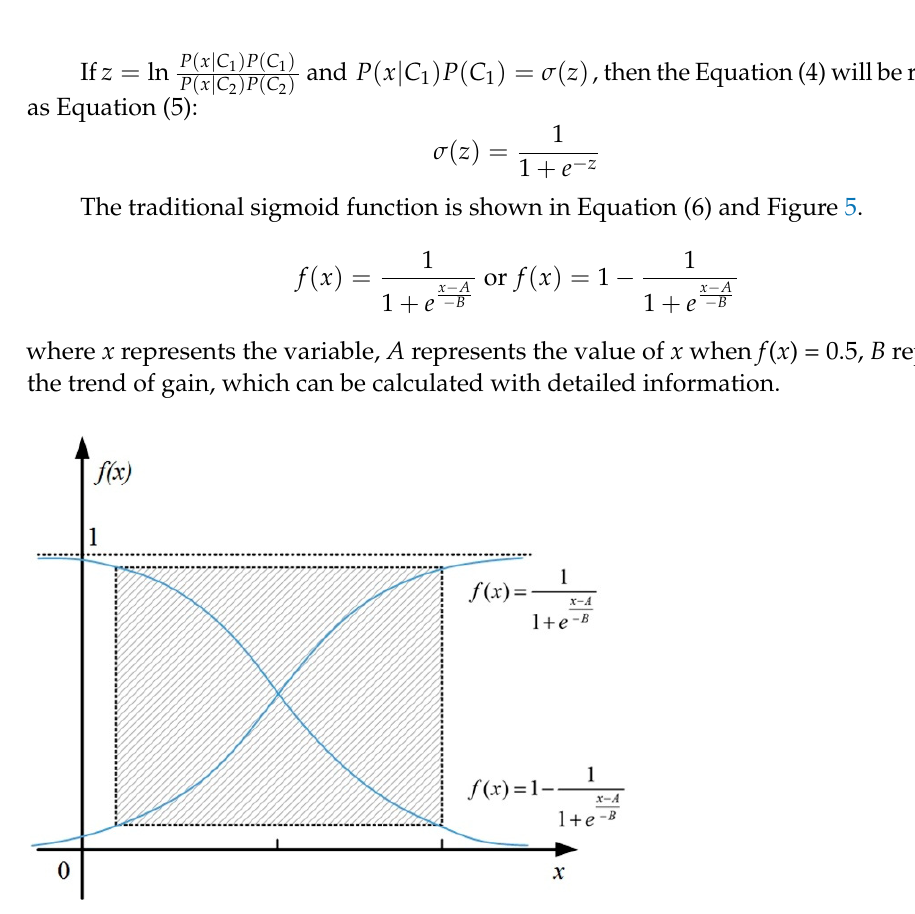
where the high slope in the middle is the sensitive area of the neuron, and the gentle slope on both sides is the inhibitory area of the neuron. Mathematically, the sigmoid function has a large signal gain for the central region and a small signal gain for the two sides,